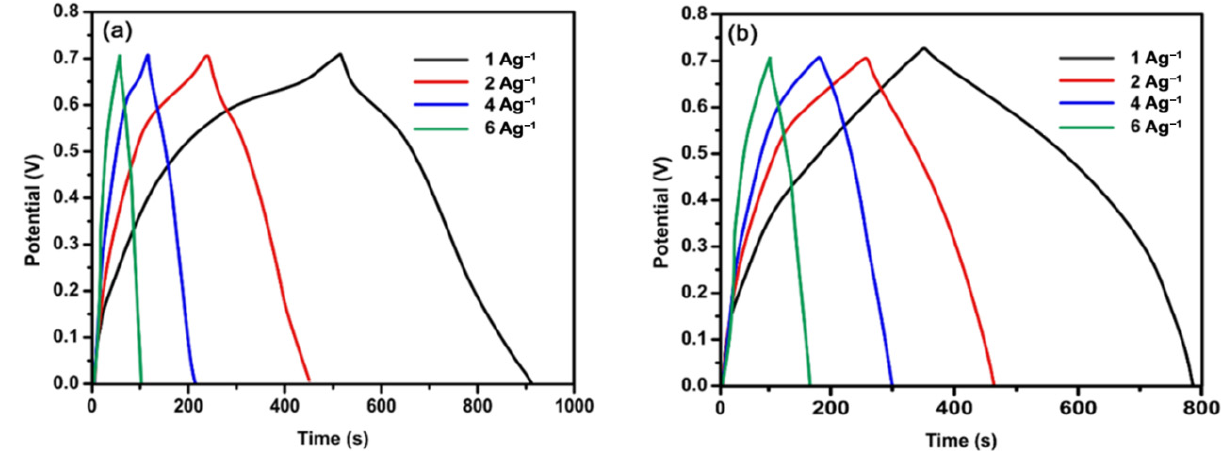
Figure 7. Galvanostatic charge/discharge measured for ( a ) PANI:PPy/AC and ( b ) PANI:PEDOT/AC in 2 M KCl.